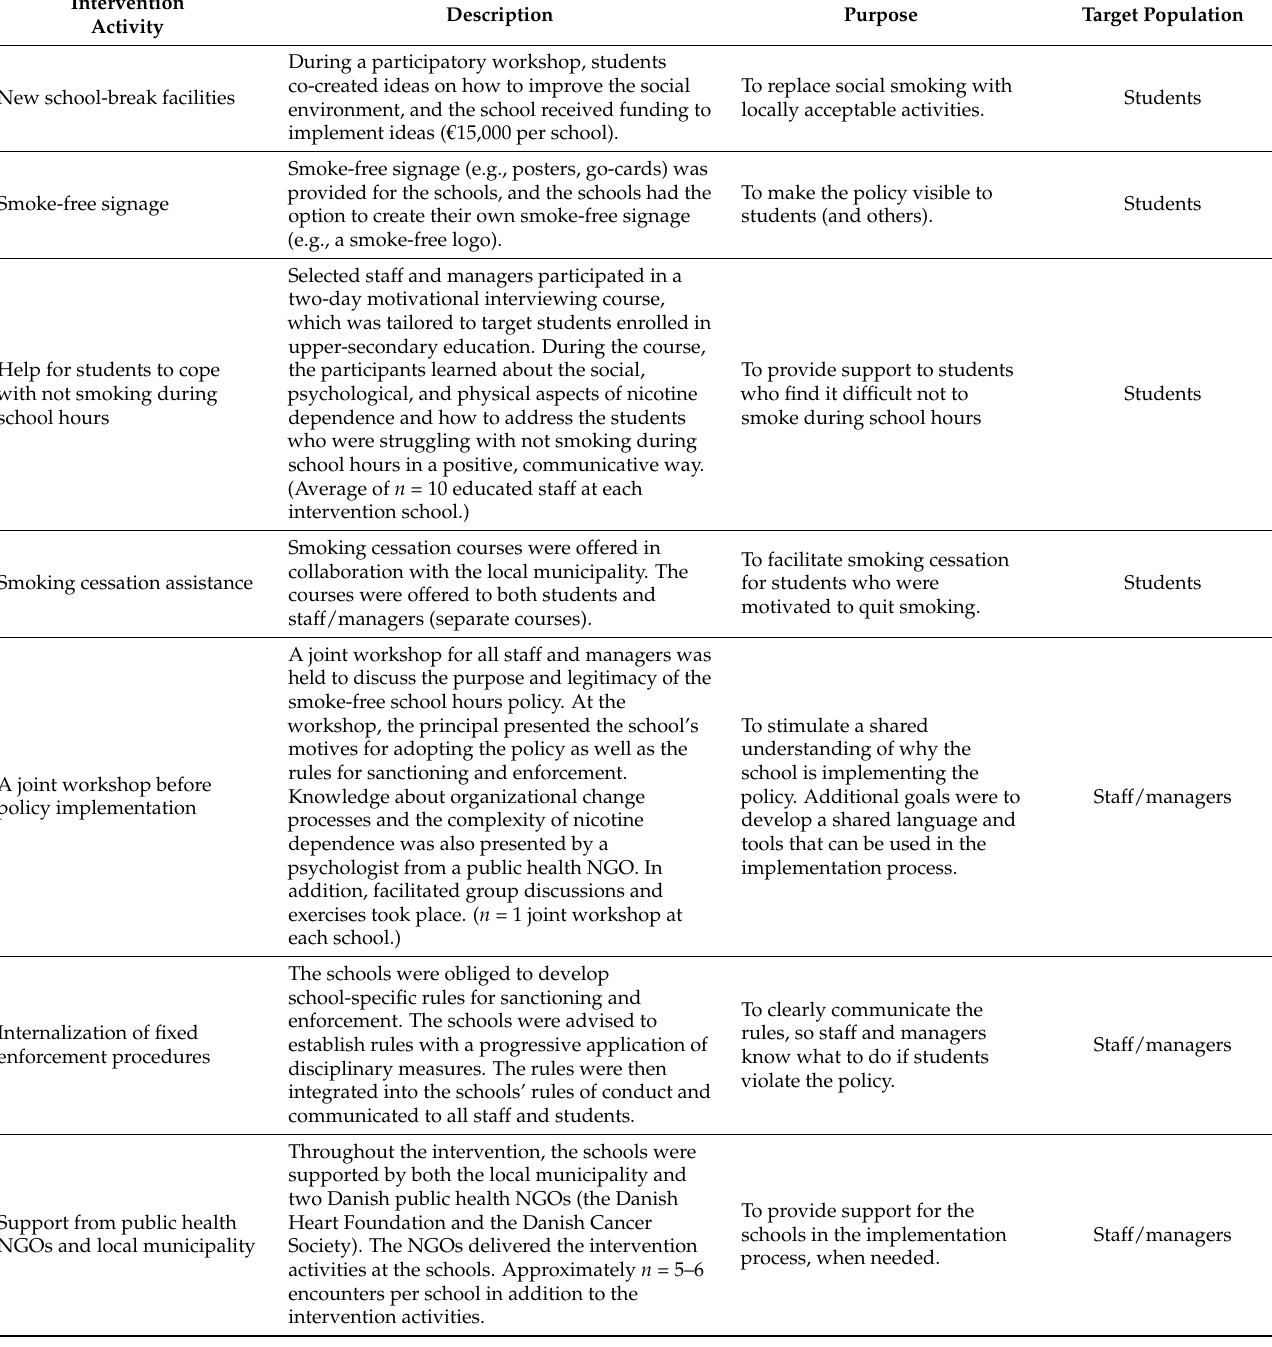
Table 1. Intervention activities at each school in the Smoke-Free Vocational Schools intervention, including purpose of activity and target population